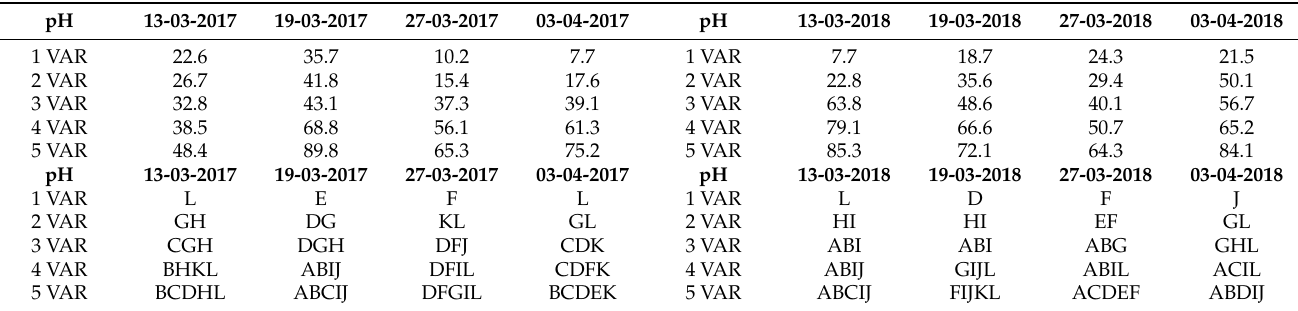
When focusing on the pH results, the comparison of R 2 in both seasons shows greater stability in the dates since the highest R 2 s are concentrated in the sampling of 19 March (Table 6). For the 2018 season, the highest R 2 s are split between 13 March and the end of March. Table 6. Summary of R 2 for pH. R 2 obtained at each reporting date (upper) and the bands included in each one (lower). Band designation: A (B3); B (B4); C (B5); D (B6); E (B7); F (B8); G (B11); H (B12); I (Chlorophyll); J (GNDVI); K (NDMI); L